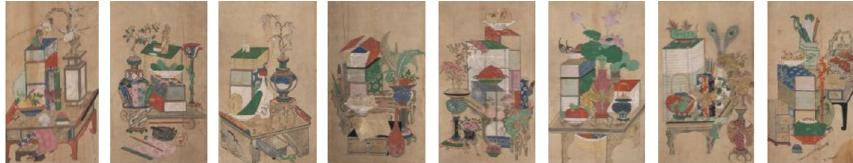
Fig. 1 Chaekgeori folding screen. Note. This figure used ’Chaekgeori’, which was written by the "National museum of Korea" and opened as the first type of KOGL, and the fugure can be downloaded for free from the ’National museum of Korea, https:// www. museum. go. kr’. [Soure: National Museum of Korea collection (2021)]